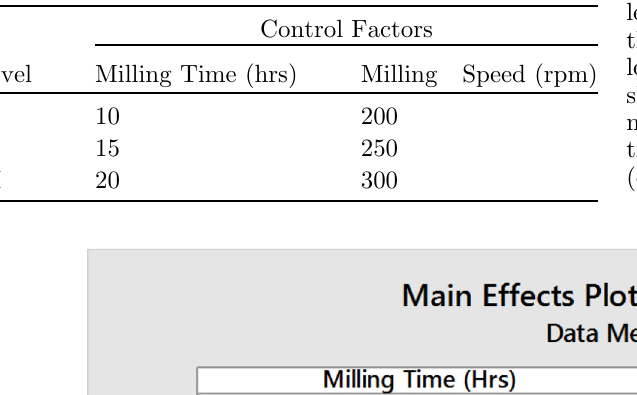
Table 2. Design of control factors and levels for Taguchi analysis.